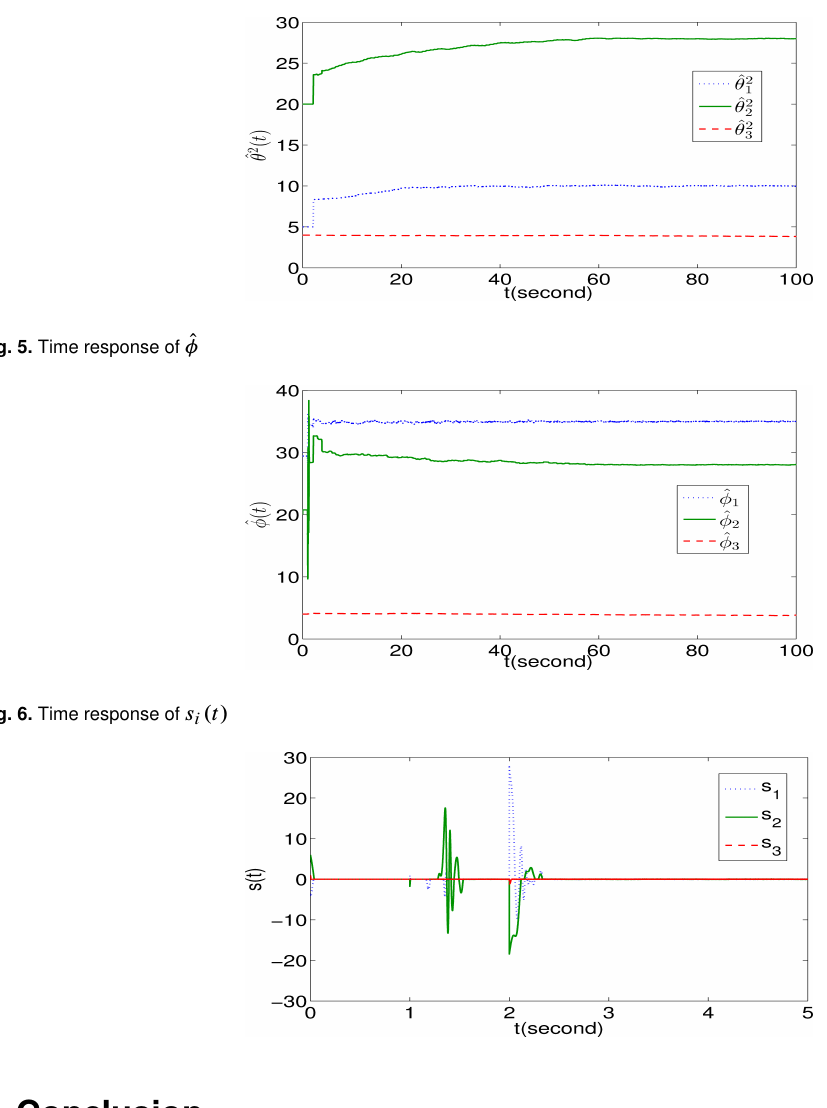
Fig. 4. Time response of